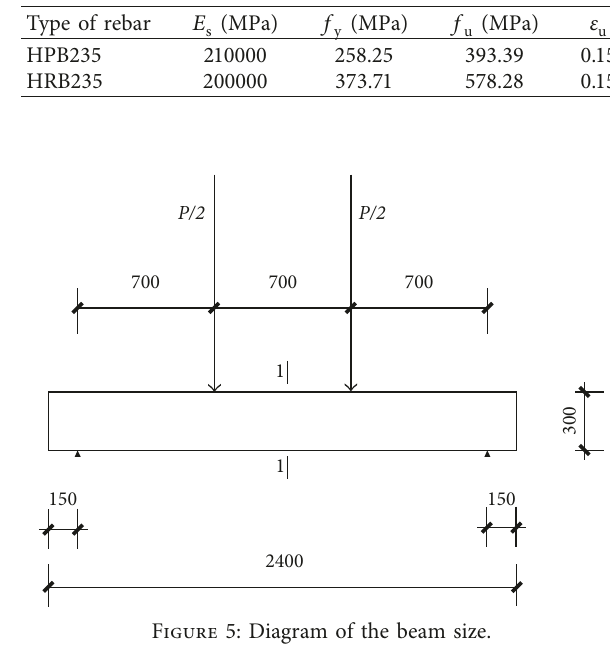
Table 3: The material parameters of rebars.